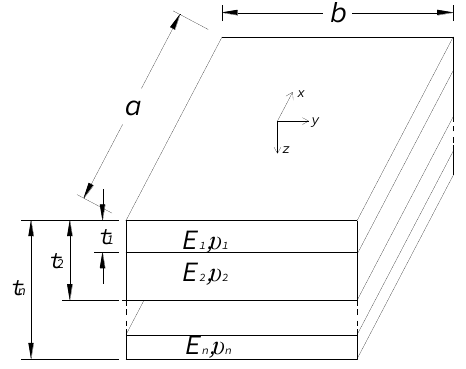
Figure 3. A composite plate with the associated system.